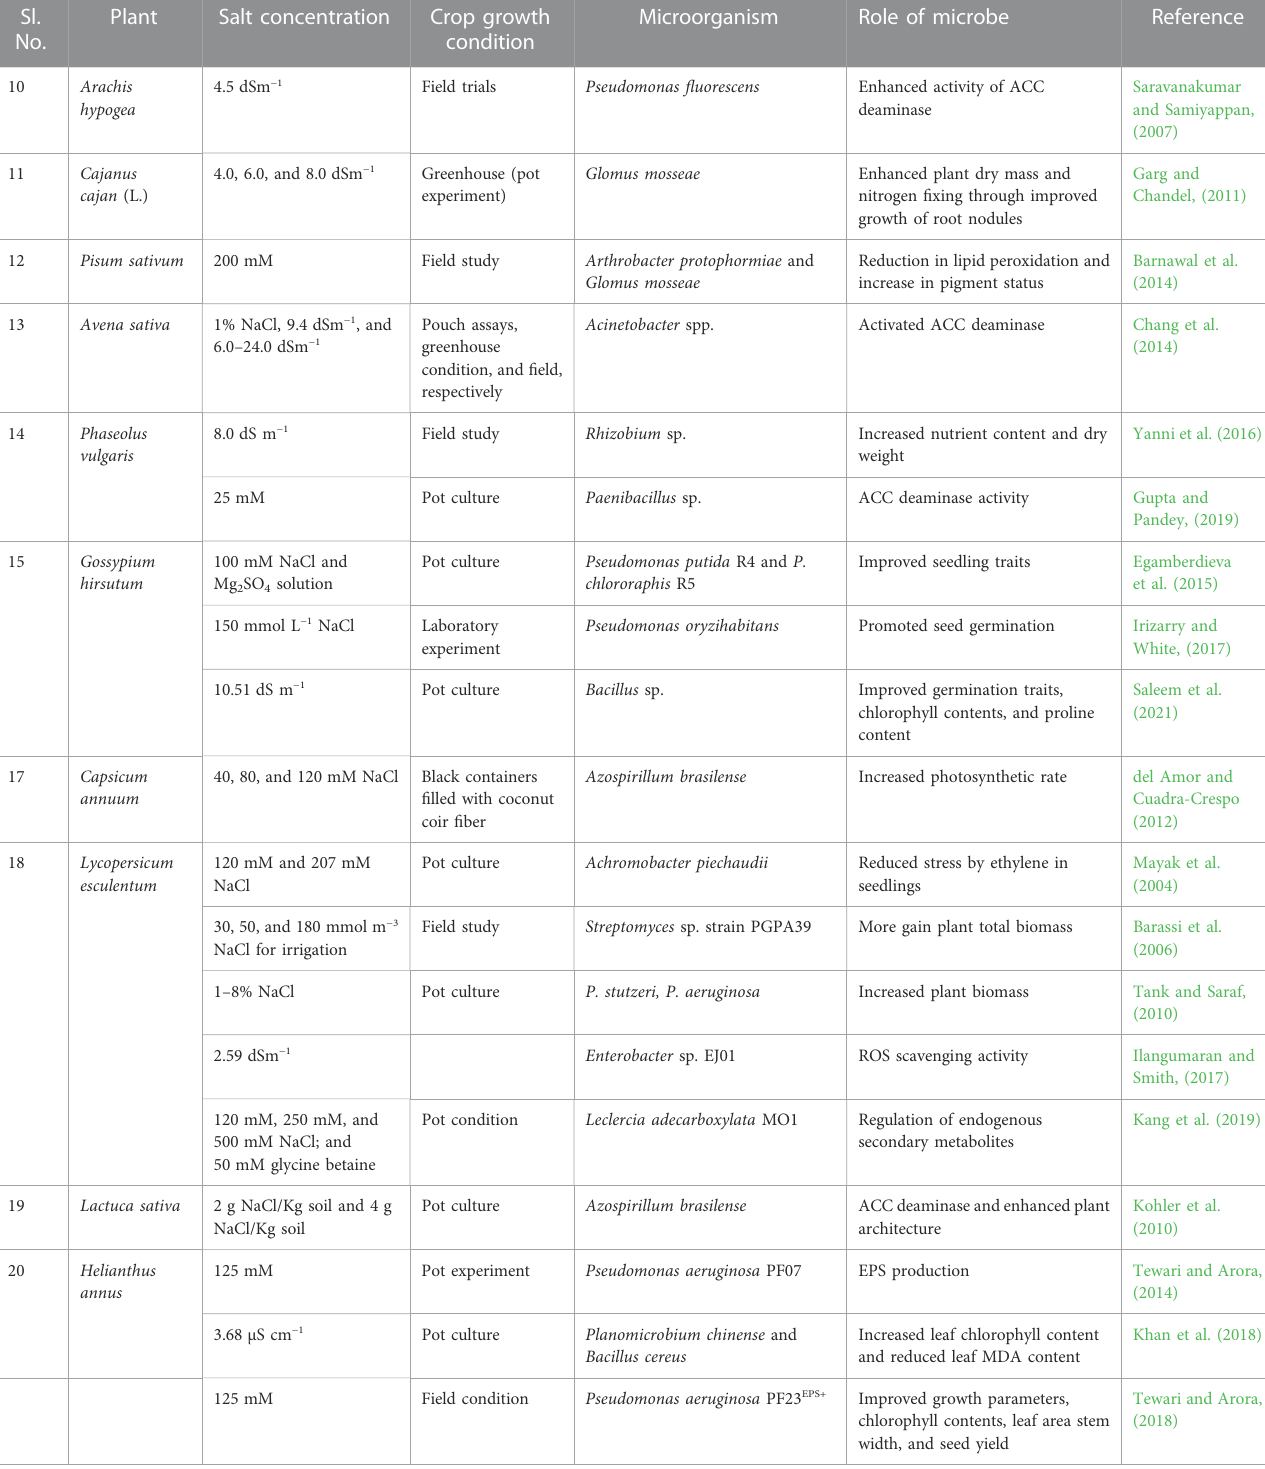
TABLE 5 ( Continued ) Effect of different microbes on plant health under salinity stress condition. Sl.